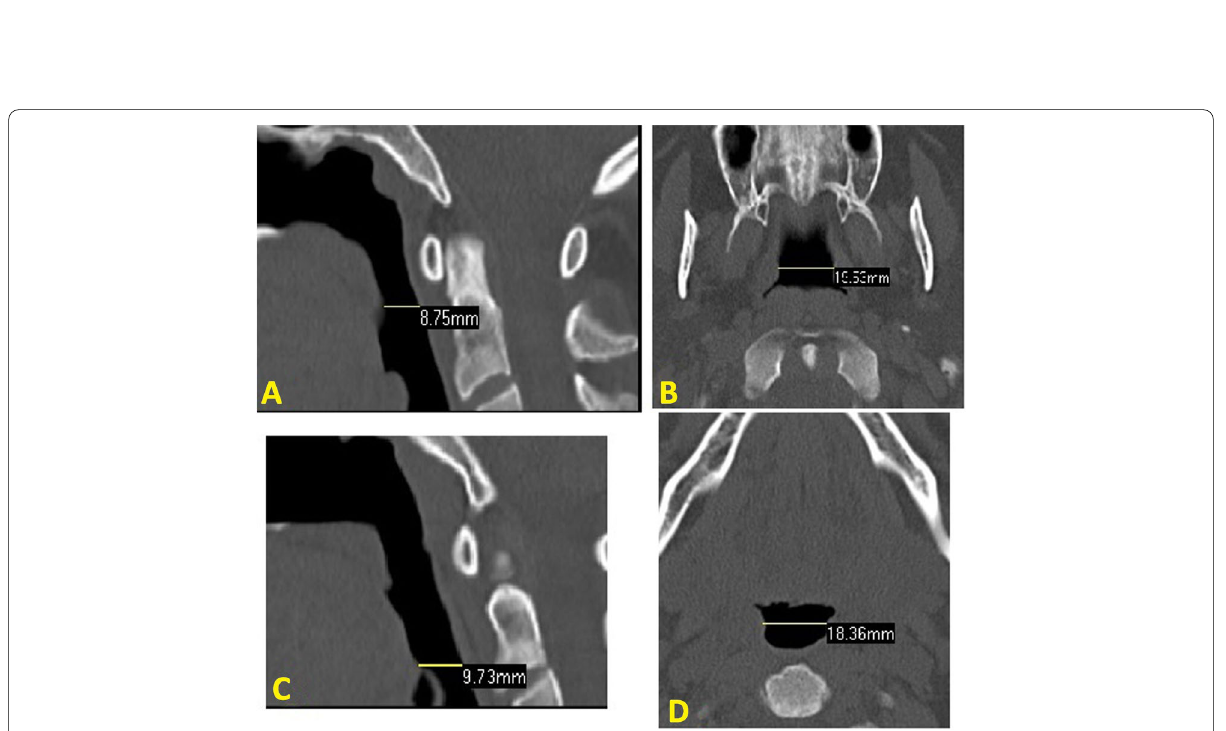
Fig. 2 CT shows measurements of the anteroposterior dimensions at the retroplatal ( A ) and the retroglossal ( C ) levels on sagittal cuts and the transverse diameter at the retroplatal ( B ) and the retroglossal ( D ) levels on axial